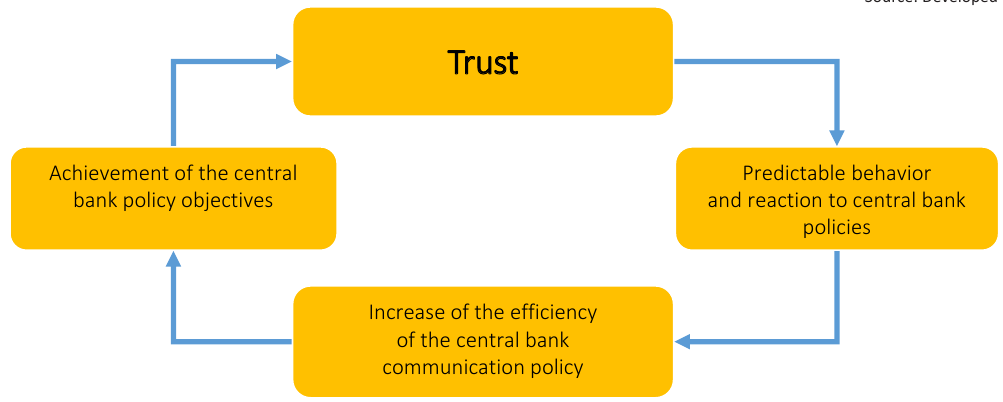
Figure 1. Interplay of trust and central bank policies’ effectiveness